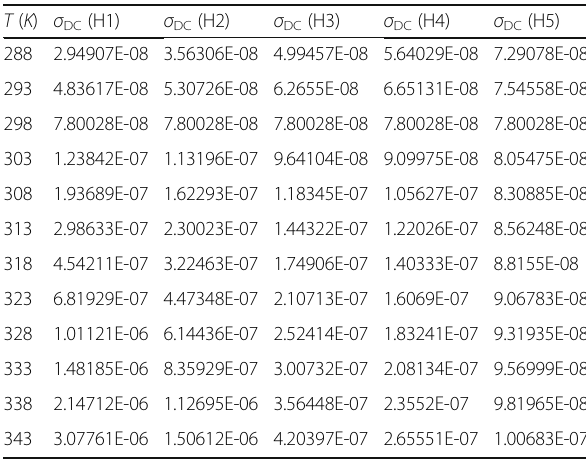
Table 3 DC electric conductivity of five energy levels corresponding to H1, H2, H3, H4, and H5; these times are used in fitting processes for AC-complex conductivity: electric conductivity and dielectric